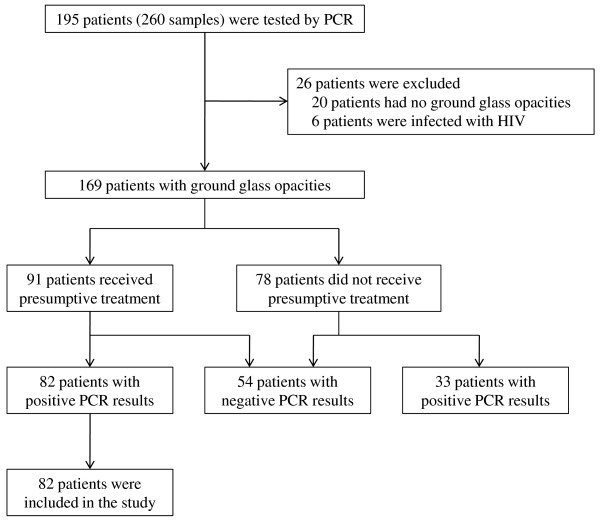
Inclusion of patients. PCR: polymerase chain reaction; HIV: Human Immunodeficiency Virus.